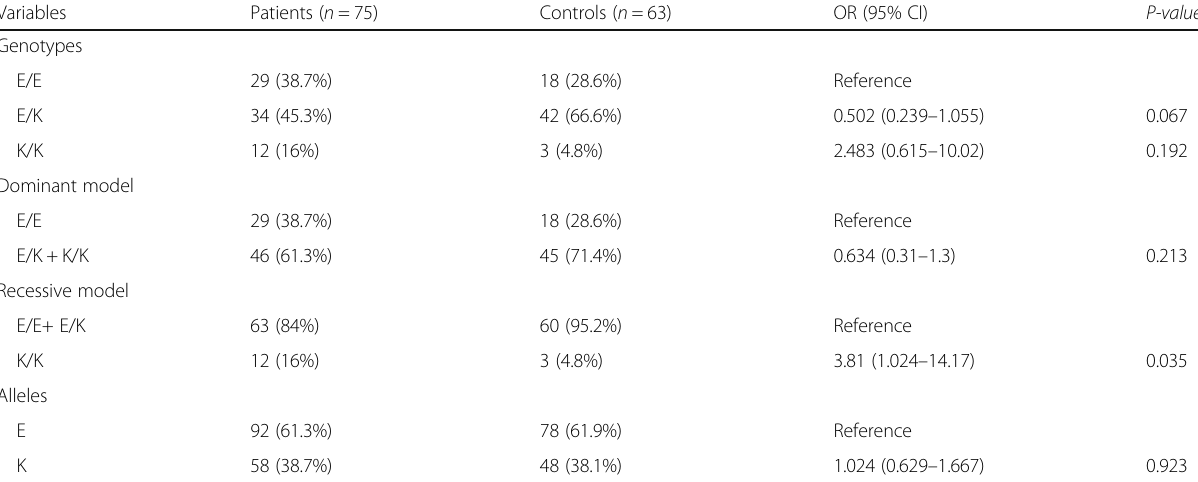
Table 2 Genetic characteristics of the T2DM patients and control groups Variables Patients ( n = 75)